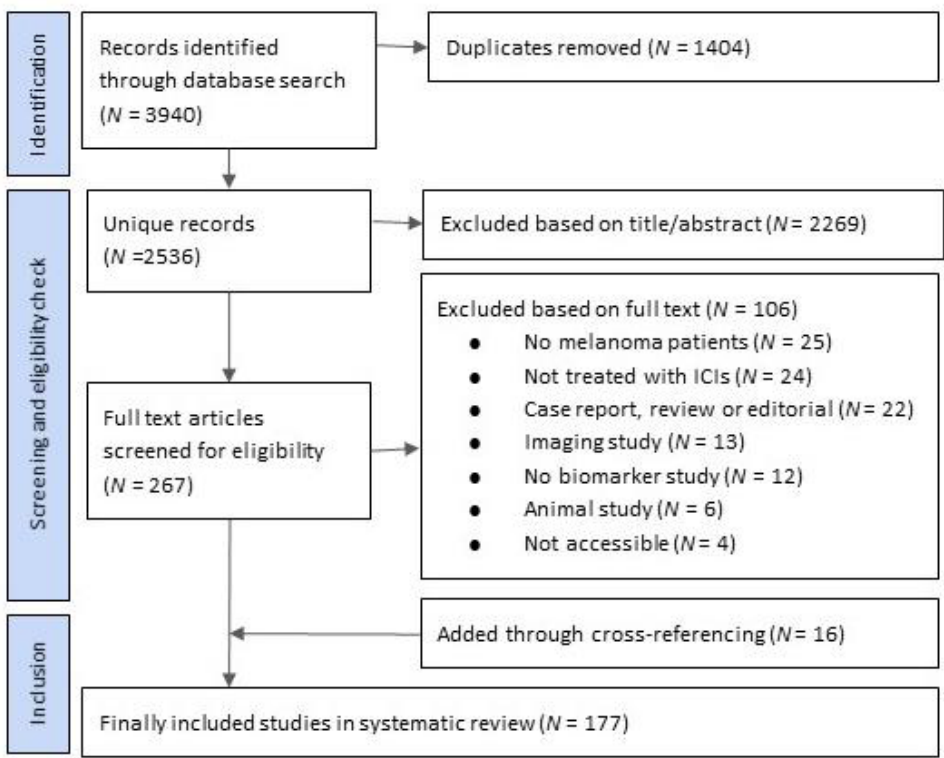
Table 1. Summary of most important biomarkers that were studied for anti-CTLA-4 therapy and assessed risk of bias per article. N of Biomarker